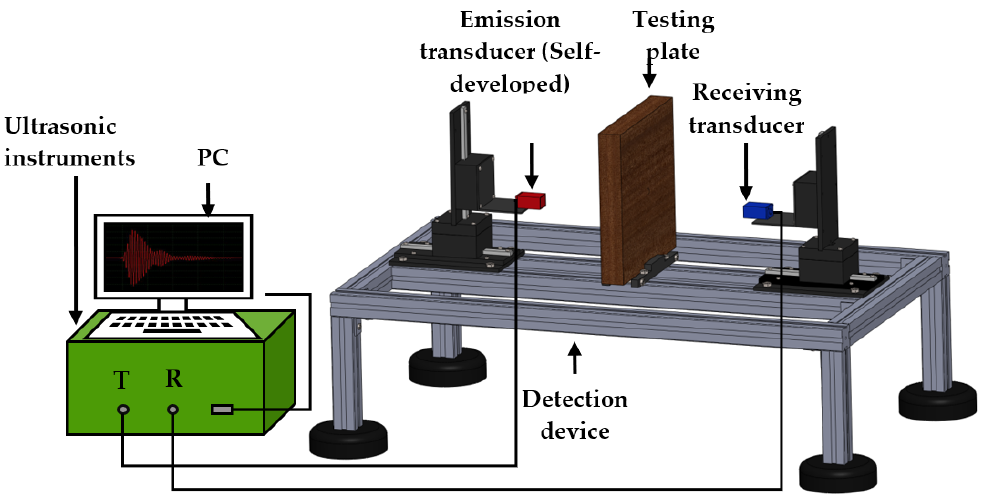
Figure 4. Testing platform.